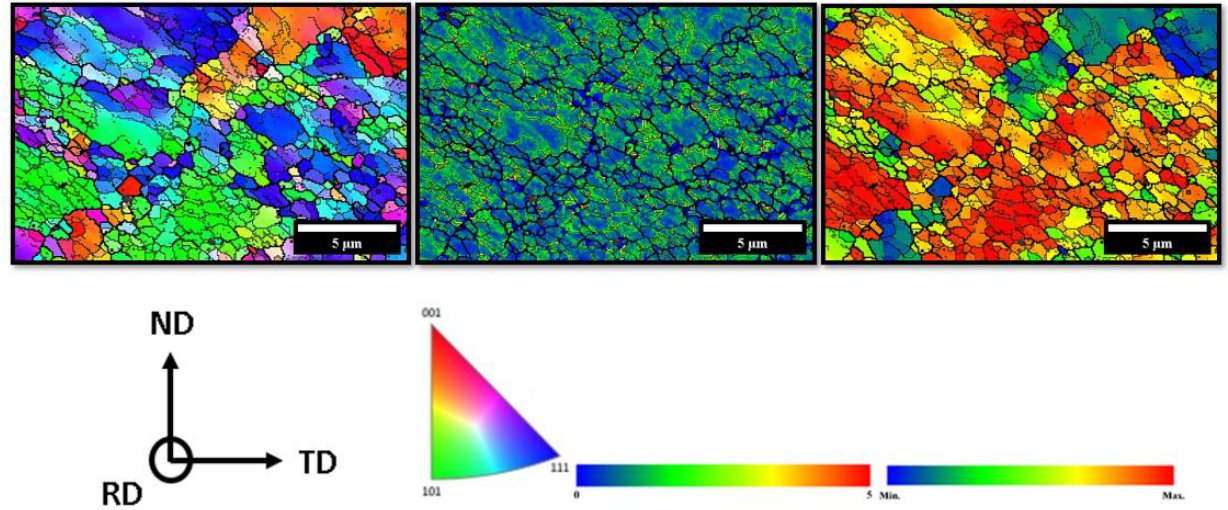
Figure 4. Orientation maps (OIM) of the as-received (AR) sample in the normal direction (ND), third-order kernel average misorientation (KAM) map, and Taylor factor map.